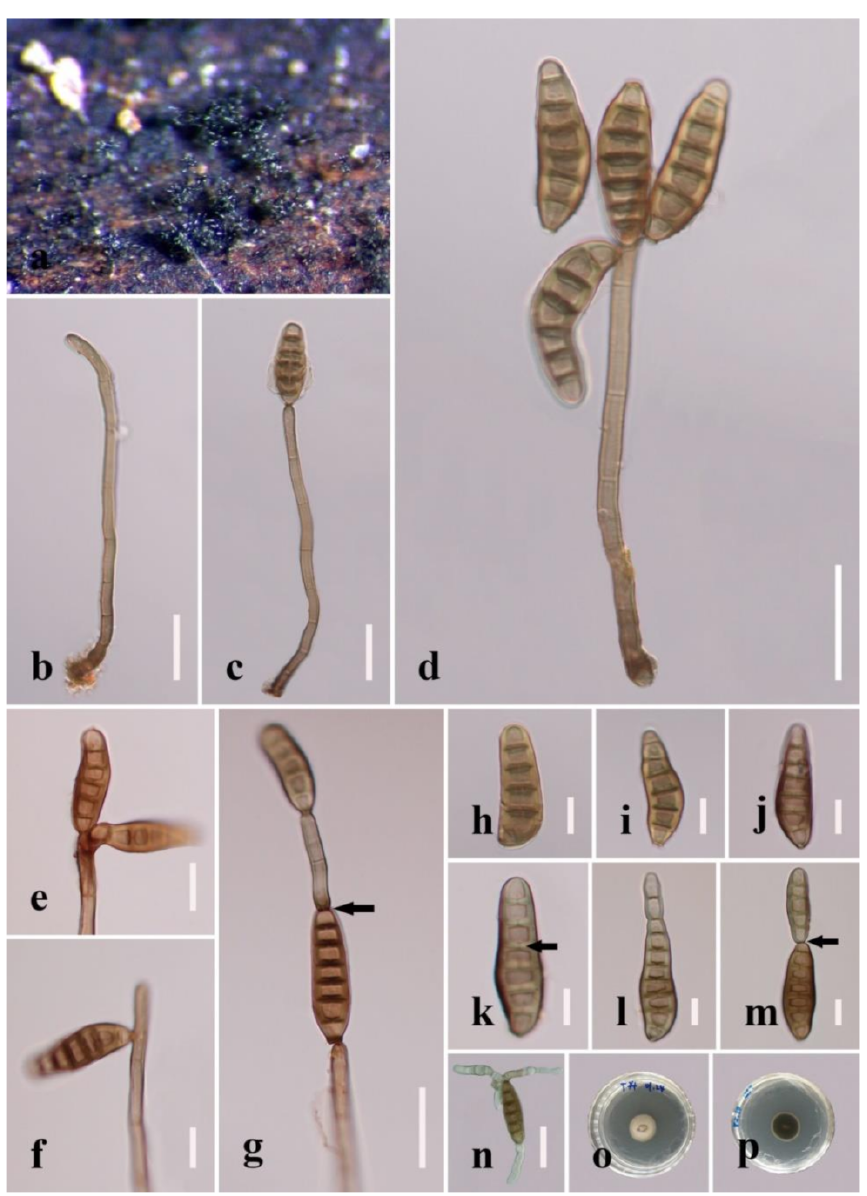
Figure 9. Distoseptispora dehongensis (from MFLU 19–0544). ( a ) Colonies on natural substrate. ( b ) Coni- diophore. ( c , d ) Conidiophores with conidia. ( e – g ) Conidiogenous cells bearing conidia. Note the conidium with percurrent proliferation that is forming another conidium in g . ( h – m ) Conidia. Arrow in k points a gap in the middle of septum, which indicateds the distoseptate, note the percurrently proliferating conidium in m ; ( n ) Germinated conidium. ( o ) Colony on PDA (from front). ( p ) Colony on PDA (from reverse). Scale bars: ( b – c , n ) 20 µ m; ( d , g ) 30 µ m; ( e , f , h – m ) 10 µ